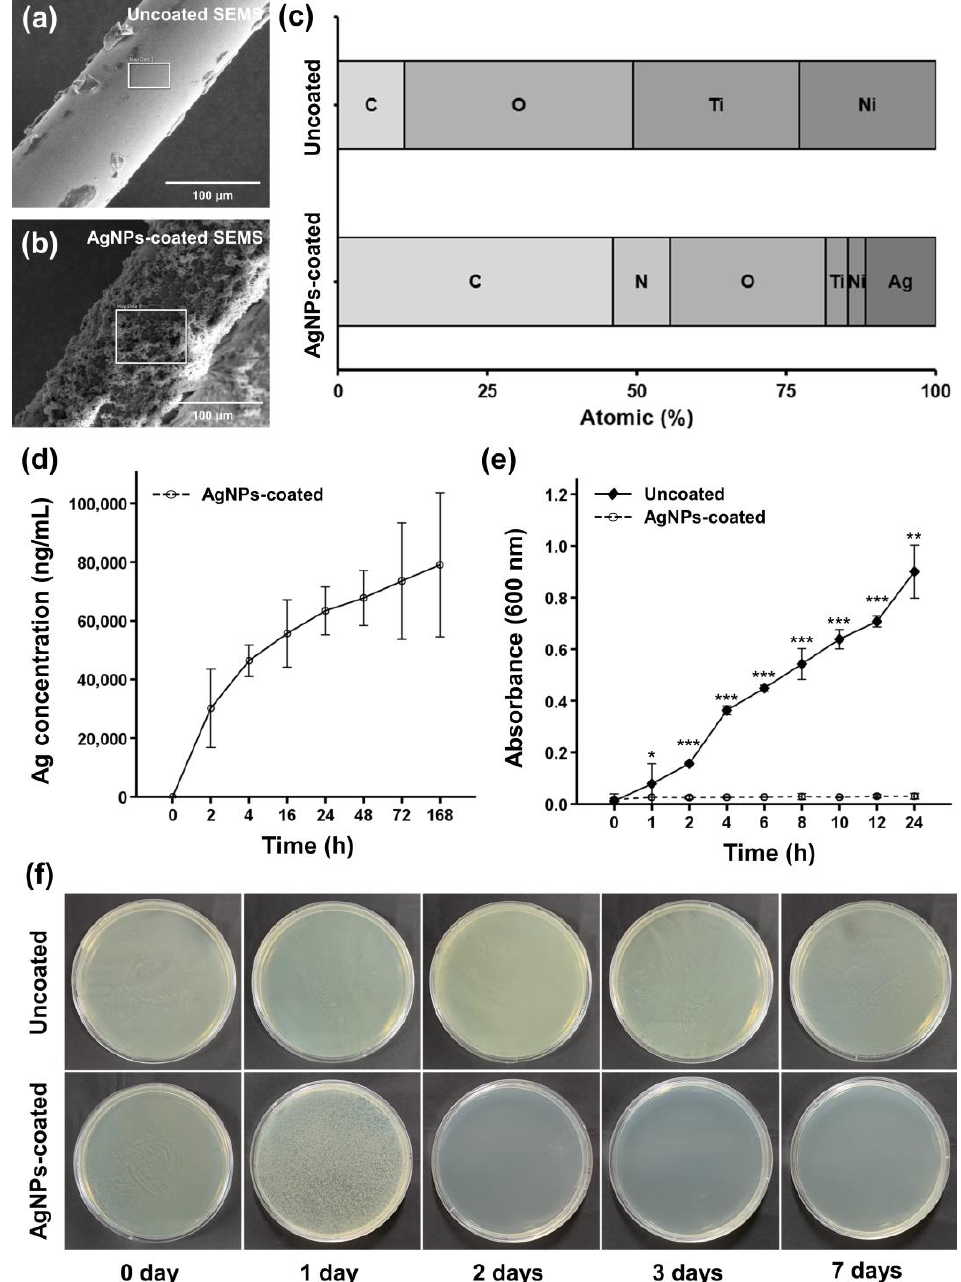
Figure 2. Surface and in vitro antibacterial characteristics of the uncoated and AgNPs-coated SEMSs. Scanning electron microscopy images of the ( a ) uncoated SEMS and ( b ) AgNPs-coated SEMS. ( c ) Elemental analysis through energy-dispersive X-ray spectroscopy confirmed that Ag was not present in the uncoated SEMS and was present in the AgNPs-coated SEMS. ( d ) Ag ions were rapidly released in the initial 2 h, and the amount of Ag ions released then gradually decreased. Bacterial activity at ( e ) 24 h and ( f ) 7 days showed that AgNPs-coated SEMS significantly inhibited bacterial growth compared to uncoated SEMS; * p < 0.05; ** p < 0.01; *** p < 0.001.